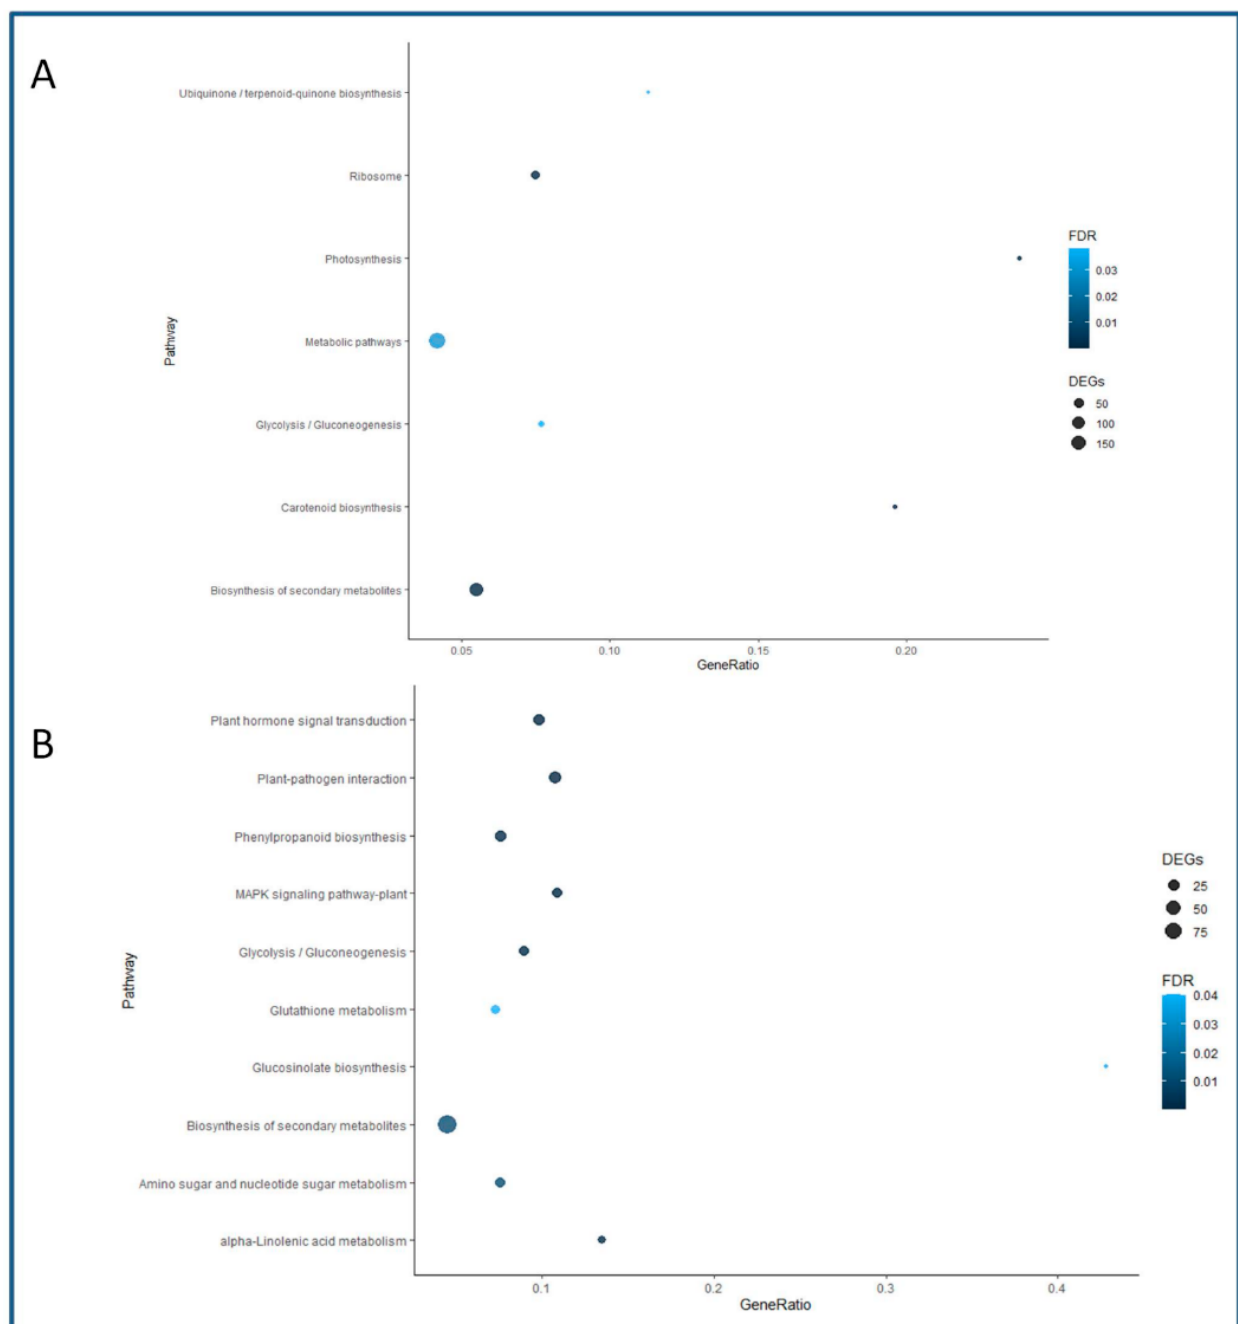
Figure 5. Enriched pathways in the KEGG analysis. The name of the pathway is shown on the Y axis, and the proportion of genes identified in the libraries with respect to the total number of genes in the corresponding pathway is given on the X axis as Gene Ratio. The size of the dots indicates the number of genes detected, and the color indicates the value for the False Discovery Rate (FDR). ( A ) Enriched pathways in the BS samples. ( B ) Enriched pathways in the CR